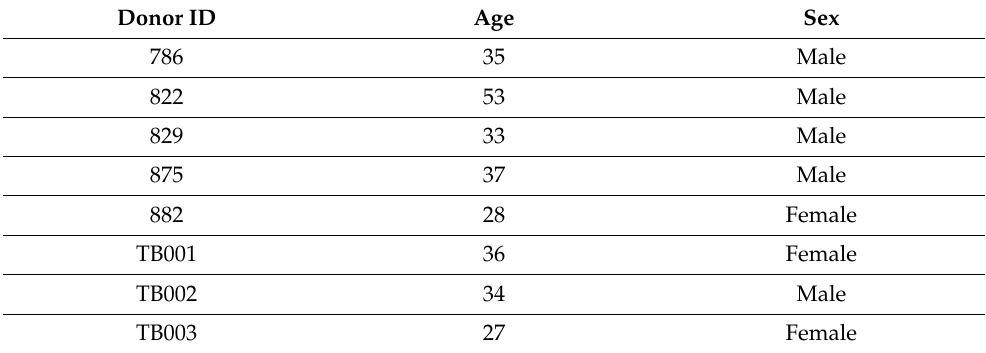
Table 1. Demographics of hMSC